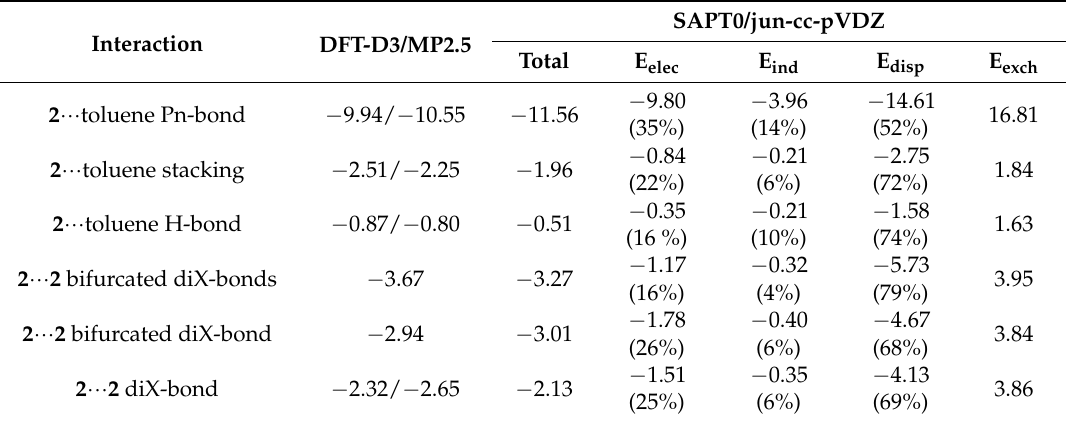
Table 3. Computed DFT-D3/TPSS/TZVPP and MP2.5/CBS two-body interaction energies for